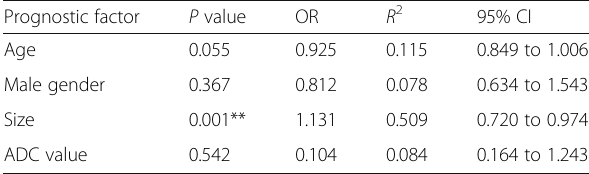
Table 4 Regression analyses for different prognostic